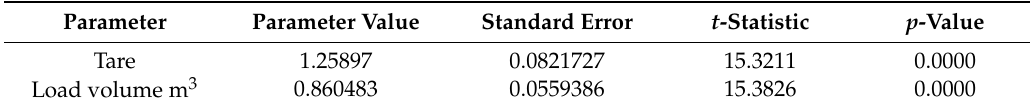
Table 5. Assessment of the model parameters for